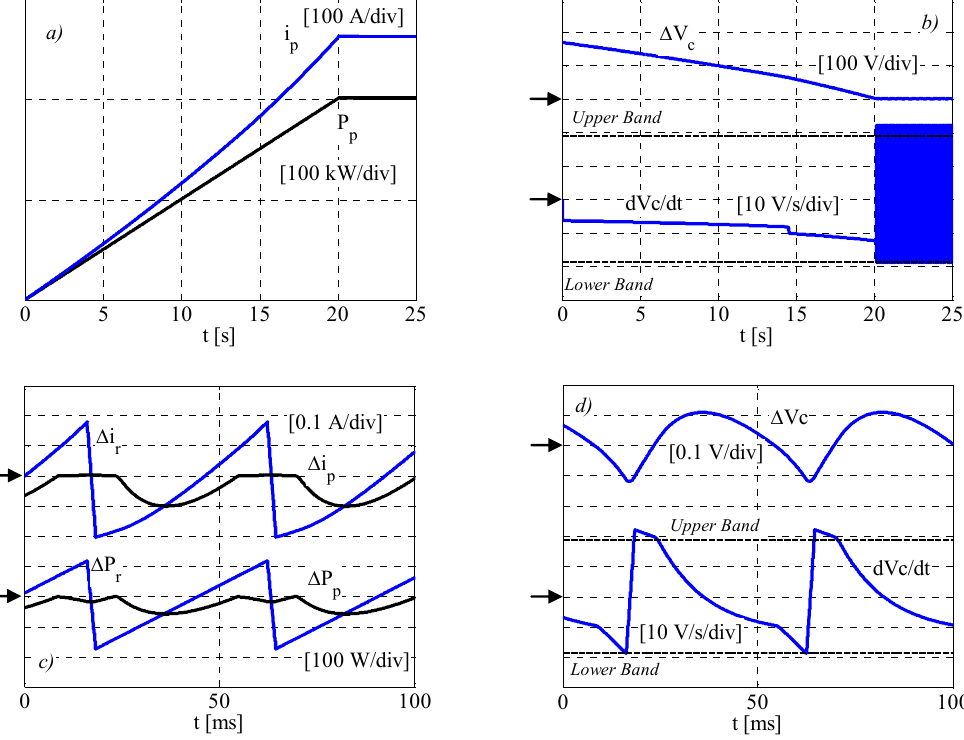
Figure 3. Ideal case numerical analysis: ( a ) PV current and power; ( b ) capacitance voltage variation time derivative; ( c ) PV and inverter current and power variation in steady state; ( d ) capacitance voltage variation time derivative in steady state.